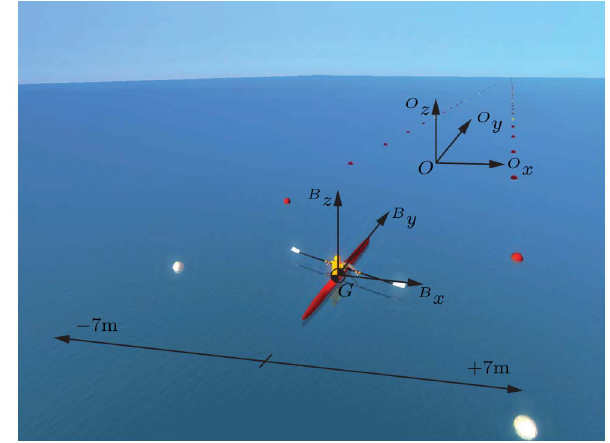
Figure 4. The training scenario was only used in the simulator group. This scenario provided some distraction for the participant during the four trainings, similar to a training environment on water. For rendering, a global coordinate system ( K O ) and boat coordinate system ( K B ) where defined. Two lines of buoys limited the rower’s workspace within the scenario. In this way the rower was in a setting comparable to a rowing race and at the same time, the rower could not leave the virtual world.